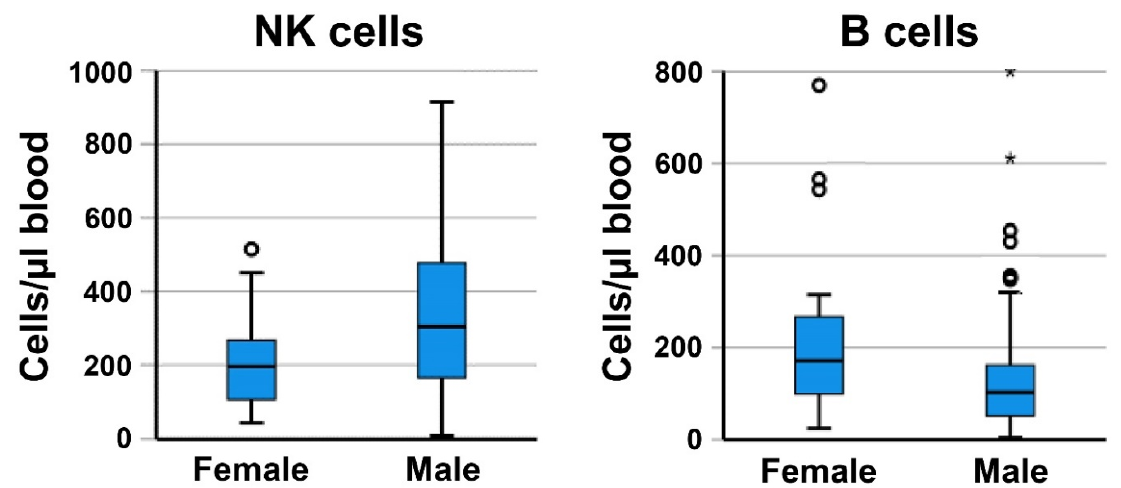
Figure 3. Comparison between baseline values of NK cells and B cells, respectively. Boxplots show a